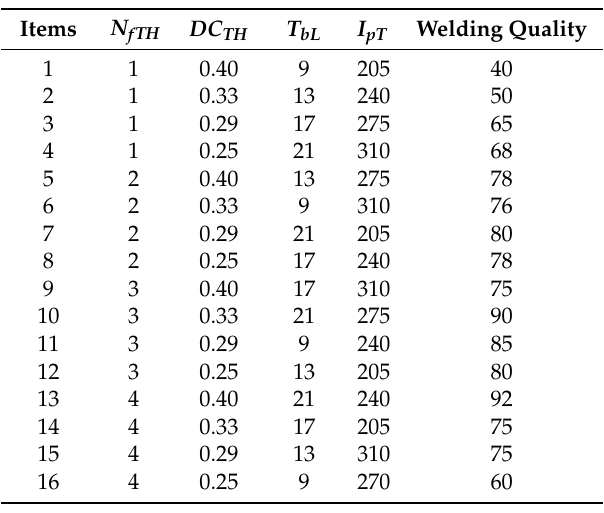
Table 2. Orthogonal test program and